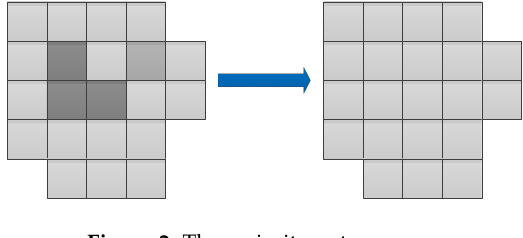
Algorithm 1: Algorithmic steps of Fast Super-Pixel Generation